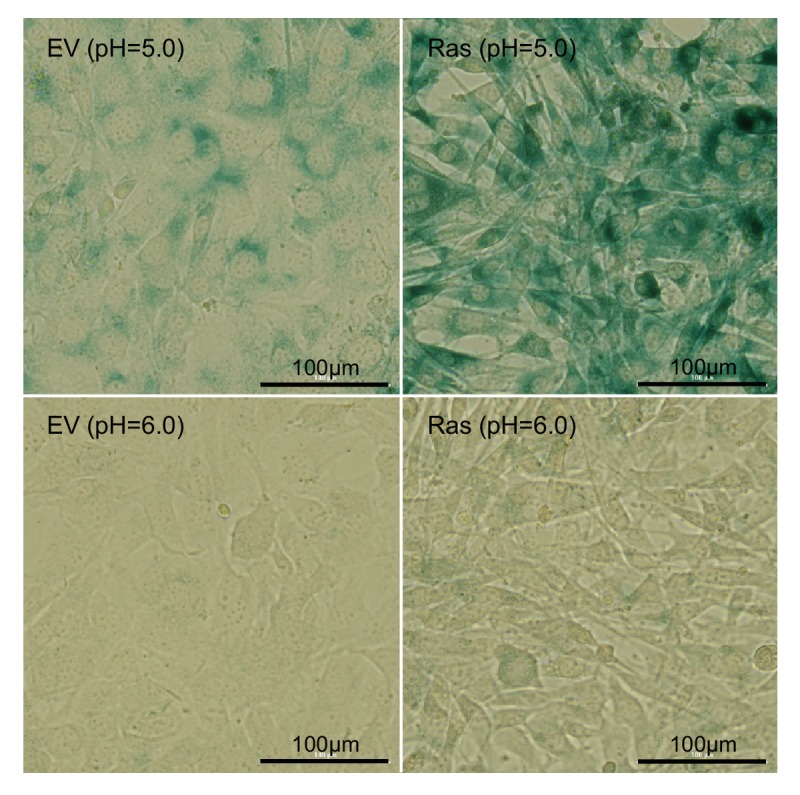
β-Galactosidase staining shows that empty vector control (EV) and H-Ras transformed fibroblasts (Ras) do not undergo senescence.Positive staining controls (pH = 5) are shown on top. Negative staining results from H-Ras transformed fibroblasts indicate that the cells are not undergoing senescence.